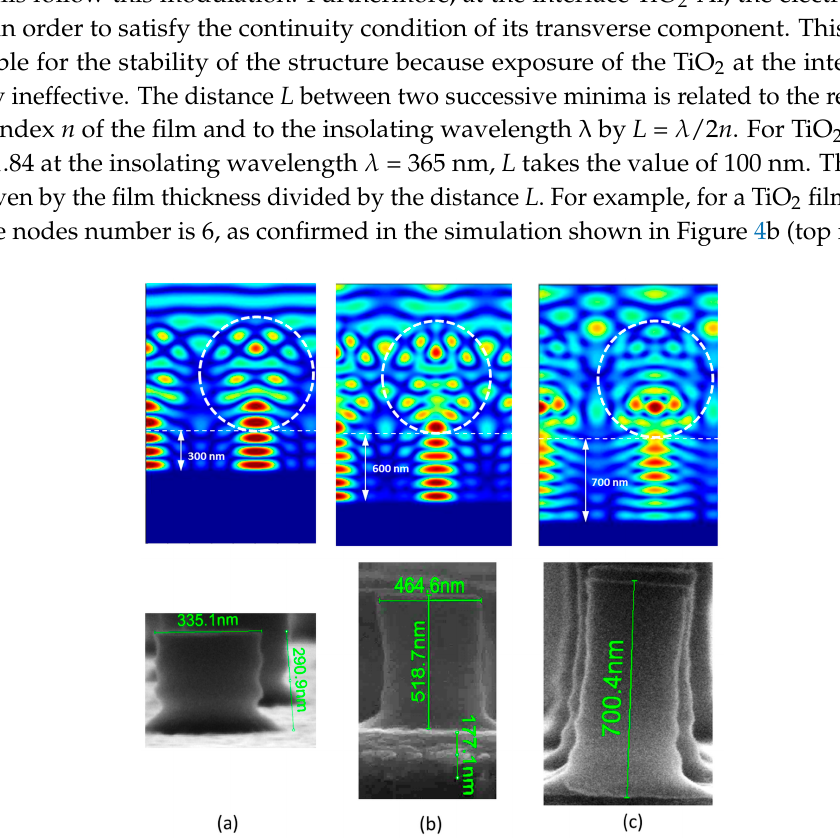
Figure 4. Simulation mapping of the electric field and SEM of the corresponding nanopillar with TiO 2 initial film thickness of: ( a ) 300 nm; ( b ) 600 nm; and ( c ) 700 nm.